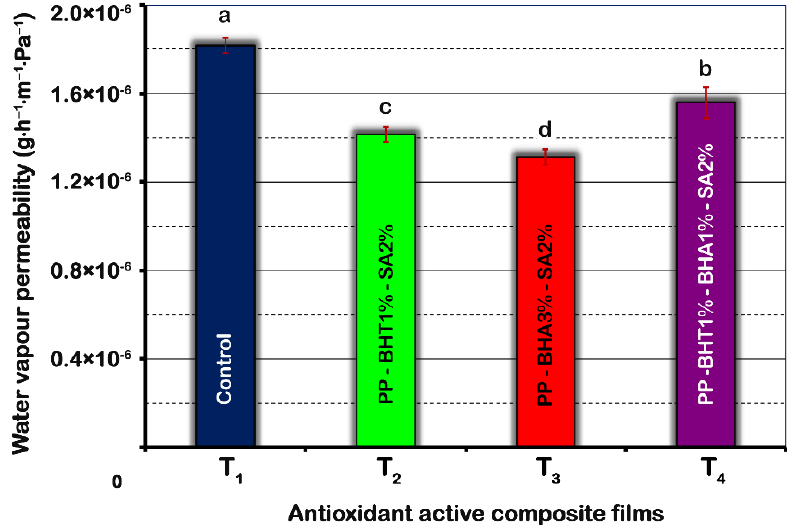
Figure 1. Effect of composition of polypropylene-based films on water vapour permeability (WVP). Means ( n = 5) with different letters are significantly different ( p < 0.05). Error bars corresponding to standard deviations.